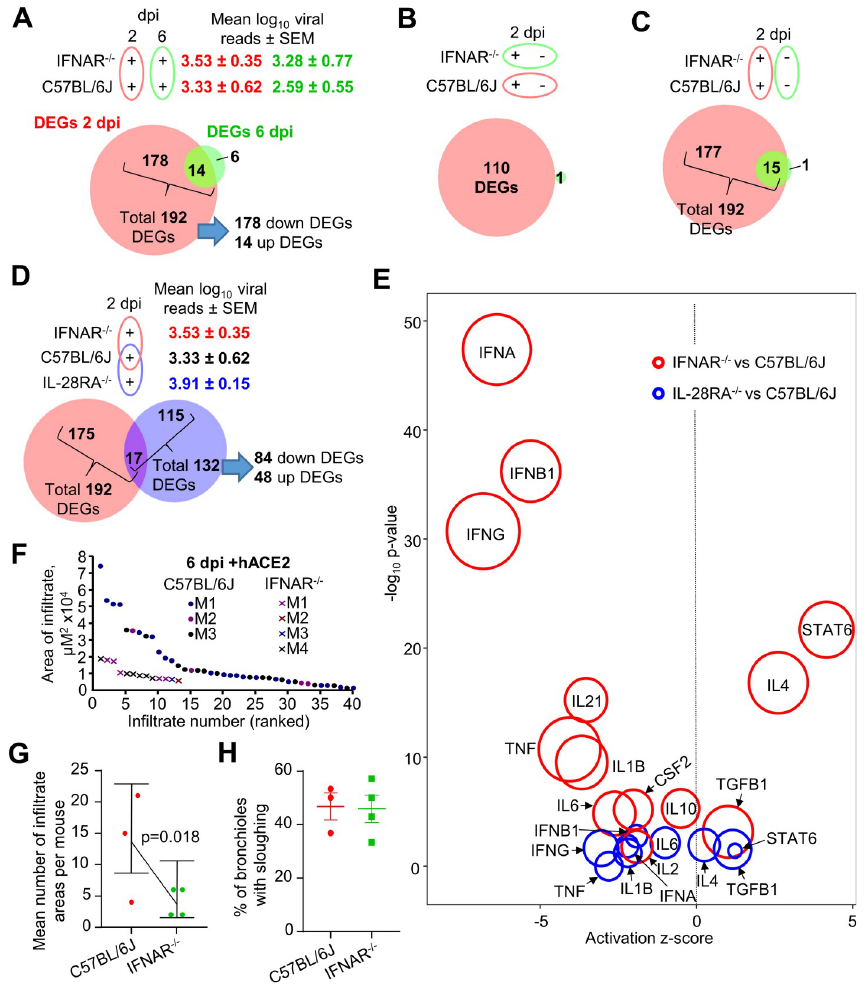
Fig 6. Type I and III IFN signaling is required for SARS-CoV-2-induced lung inflammation. A) Venn diagram for number of DEGs (FDR < 0.05) between IFNAR -/- versus C57BL/6J mice at day 2 (red) or day 6 (green). Mean log 10 SARS-CoV-2 read count in RNA-seq data ± SEM is shown (red text = day 2, green text = day 6). B) Venn diagram for number of DEGs (FDR < 0.05) between plus versus minus hACE2-lentivirus transduction comparing C57BL/6J (red) and IFNAR -/- (green) mice at day 2. C) Venn diagram for IFNAR -/- versus C57BL/6J mice at day 2 comparing hACE2-lentivirus transduced (red) or mock transduced (green) mice. D) Venn diagram comparing IFNAR -/- versus C57BL/6J (red) and IL-28RA -/- versus C57BL/6J (blue) (see S3B and S3C Dataset and S4B and S4C Dataset for full gene and DEG lists) mice at day 2 (all mice had received hACE2-lentivirus transduction). Mean log 10 SARS-CoV-2 read count in RNA-seq data ± SEM is shown (red text = IFNAR -/- , black text = C57BL/6J, blue text = IL-28RA -/- ). E) Signatures identified using IPA USR analysis of DEGs identified in ‘D’ for IFNAR -/- versus C57BL/6J (red) and IL- 28RA -/- versus C57BL/6J (blue). Circle area reflects the number of DEGs associated with each USR annotation. Signatures were selected focusing on data previously identified in ‘Fig 4C’ (entire list is in S3E Dataset and S4E Dataset). F) The areas of dense infiltrates (lesions) in lung sections from 3–4 mice per group at day 6 were measured and plotted, ranked largest to smallest lesion. Data for ‘C57BL/6J’ mice is from ‘Fig 3A’. More and larger lesions were seen in WT mice compared to IFNAR -/- mice. G) Statistics modelled lesion counts with a Poisson generalised linear model, using the square root of the sum of lesions sizes for each mouse to weight each mean. Error bars represent 95% confidence intervals. H) Bronchiolar membrane sloughing was determined when there was evidence of bronchiole epithelial cells shedding from the membrane into the lumen. The percentage of bronchioles with evidence of sloughing as a proportion of total bronchioles is shown. n = 3–4 mice per